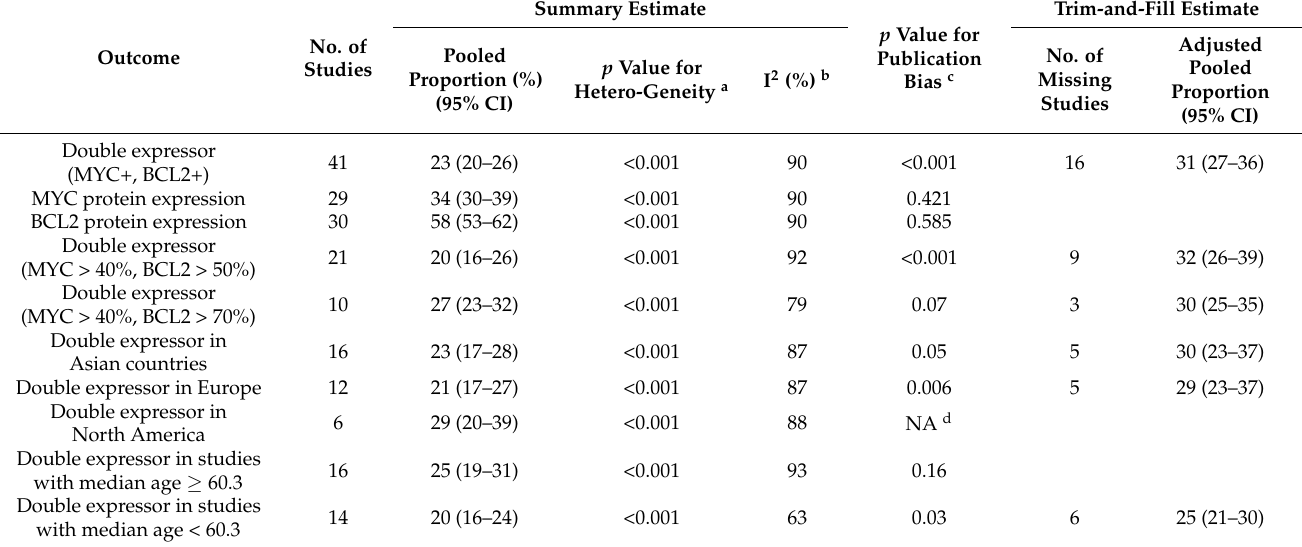
Table 3. Summary of the meta-analytic pooled prevalence for various outcomes among the included